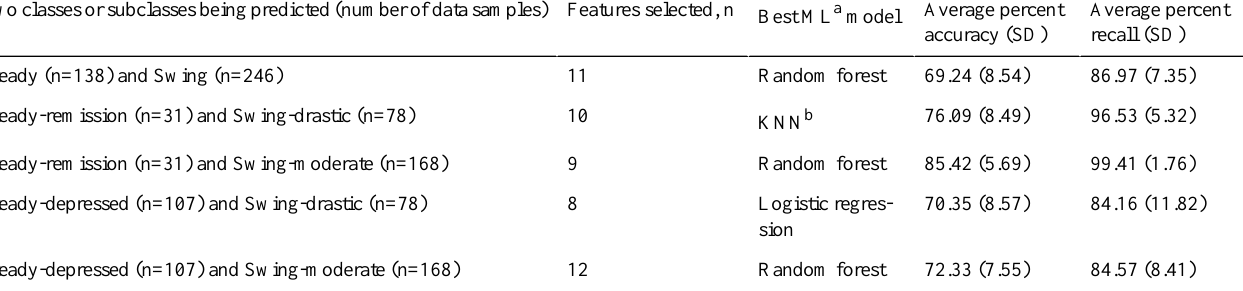
Table 5. Classification result using selected features of step count data.